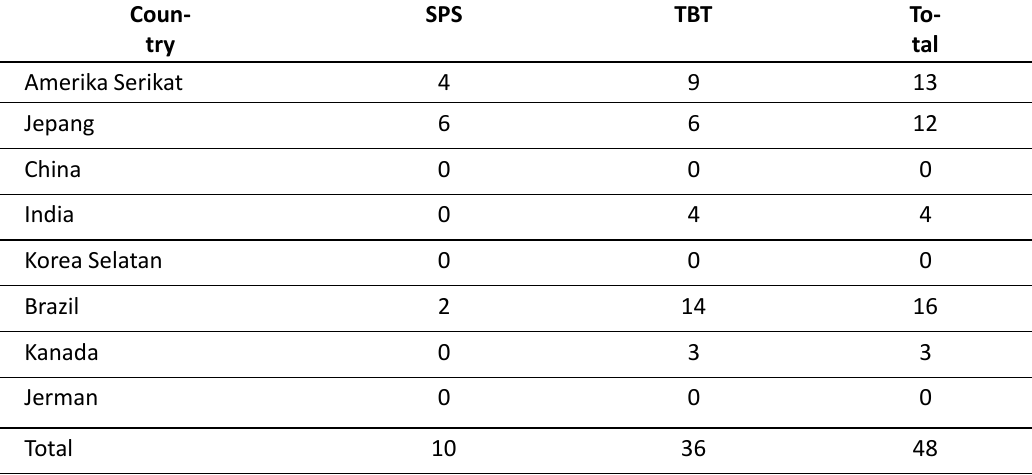
Table 3: NTMs SPS and TBT Imposed of Indonesian Natural Rubber (TSNR) by Major Destination Export Countries